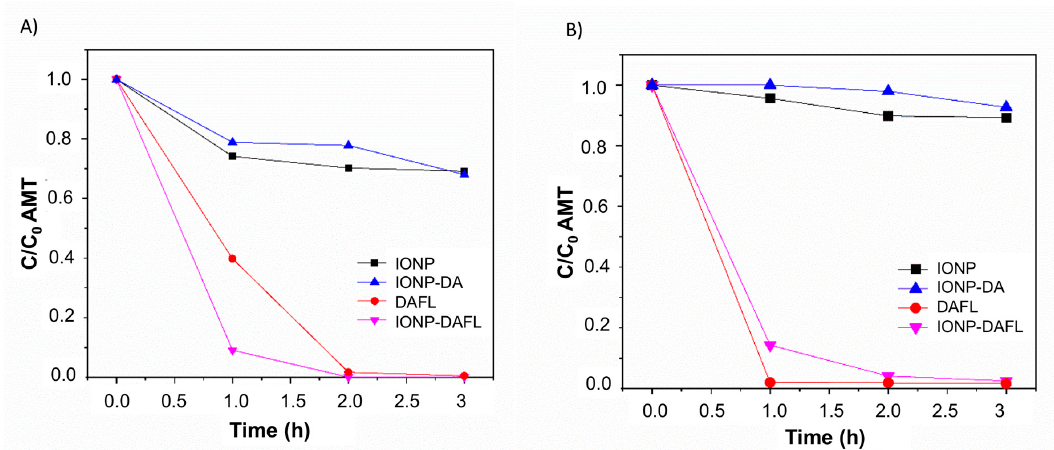
Figure 3. The relative concentration of the remaining AMT in solution (C / C 0 ) measured using UV-Vis absorption spectroscopy ( λ max = 520 nm) after irradiation with 450 nm blue light for 3 h in the presence of IONP-DAFL, DAFL, IONP, or IONP-DA in ( A ) MES (0.1 M) and in ( B ) ethylenediaminetetraacetic acid (EDTA) (0.1 M) under an O 2 environment.